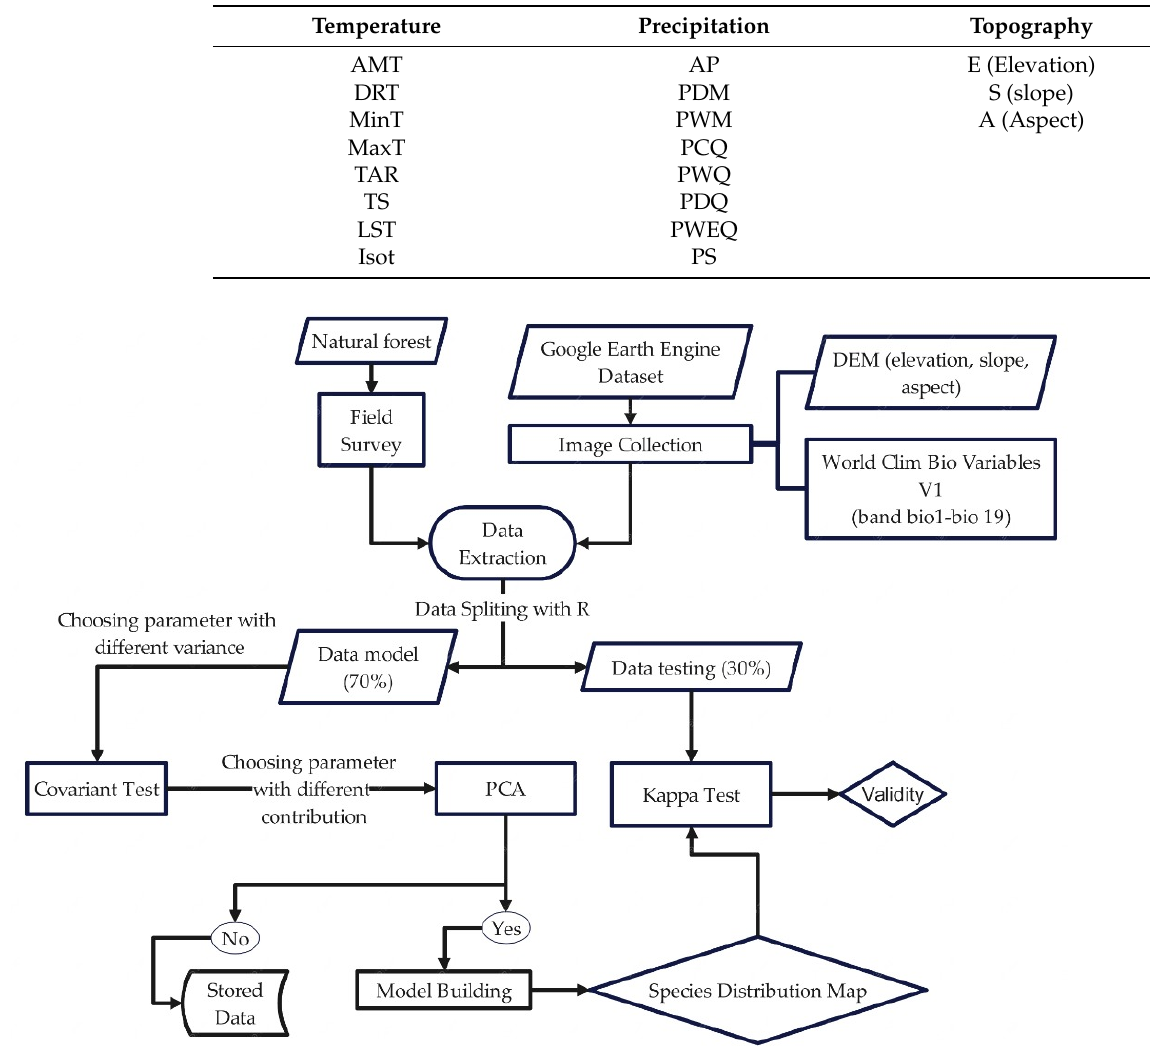
Figure 2. Flowchart of the methodology used to identify Magnolia and M. sulawesiana distribution. Table 2. Classification of Magnolia spp. distribution prediction based on covariance model analysis.